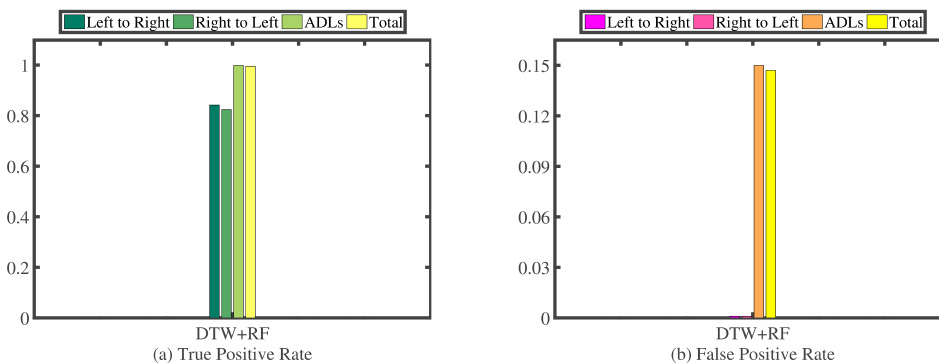
Figure 26. TPR ( a ) and FPR ( b ) of RF along with